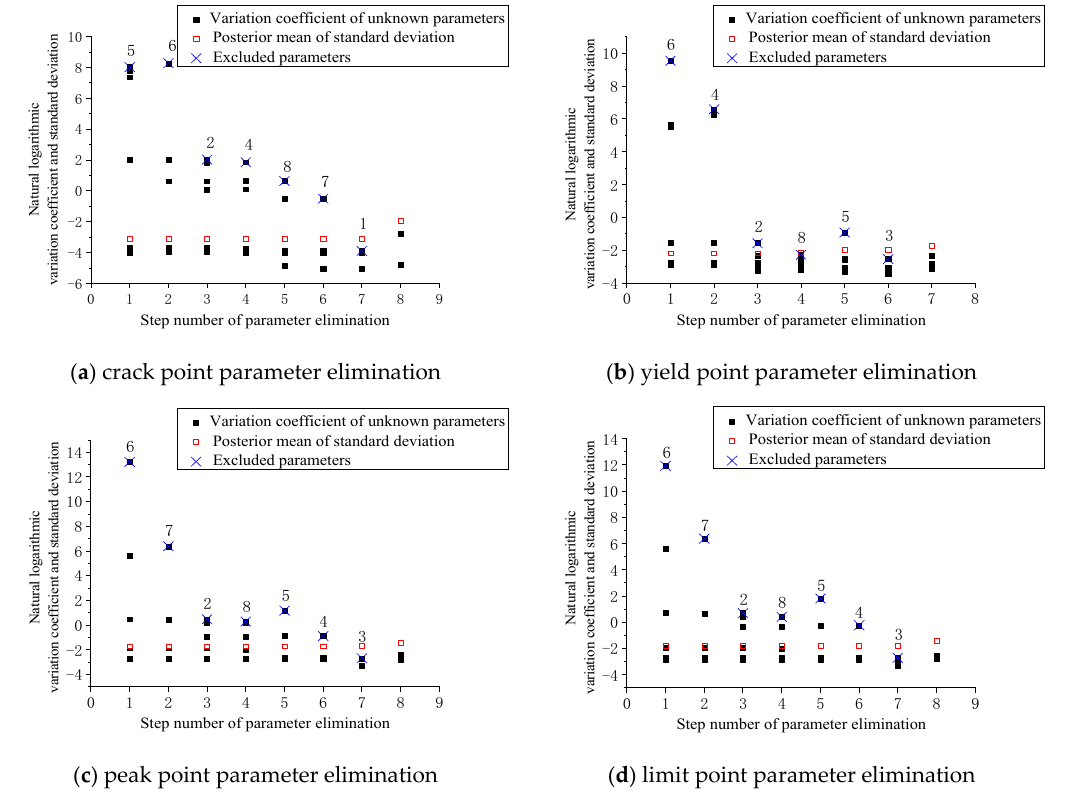
Figure 5. Remove the parameters of the performance point.